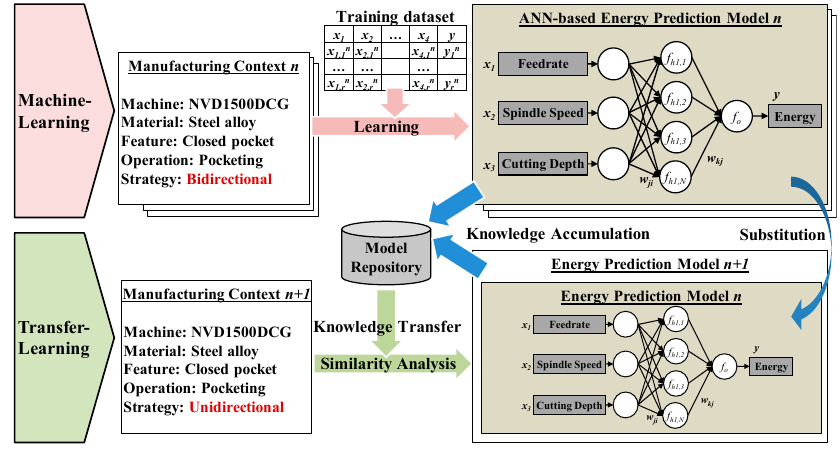
Figure 3. The concept of hybrid learning. ANN: Artificial Neural Network. Table 2. A similarity matrix of energy patterns in 2.5 dimensional pocketing strategies .